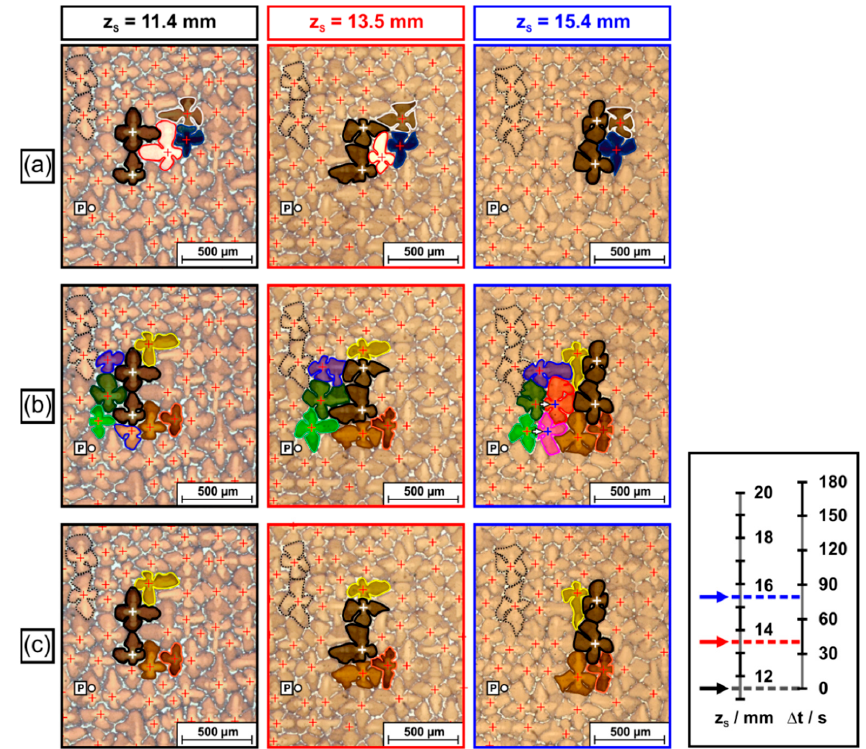
Figure 16. Specific aspects of interactions between dendrites, isolated from the image series in Figure 15. ( a ) Overgrowth of matrix dendrites by slightly misaligned dendrites. ( b ) Branching events and formation of tertiary dendrites behind the growth path of misaligned dendrites. ( c ) Early stages of branching of dendrites located close to the growth paths of misaligned dendrites. For details, see text.